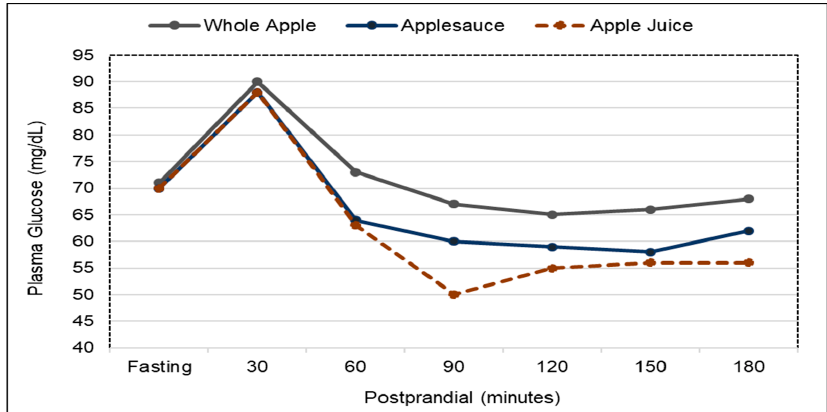
Figure 15. Mean postprandial plasma glucose levels after eating whole apples, applesauce, and apple juice (applesauce and apple juice plasma glucose significantly fell below whole apple levels after 75 to 180 min [ p < 0.05]) [221].